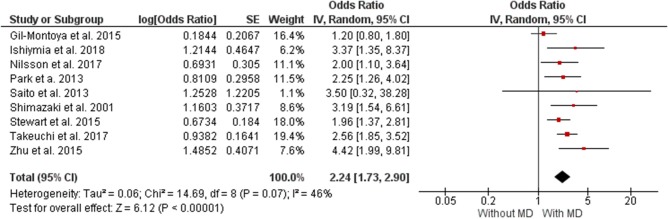
Forest plot of log OR between masticatory dysfunction and cognitive deficit.